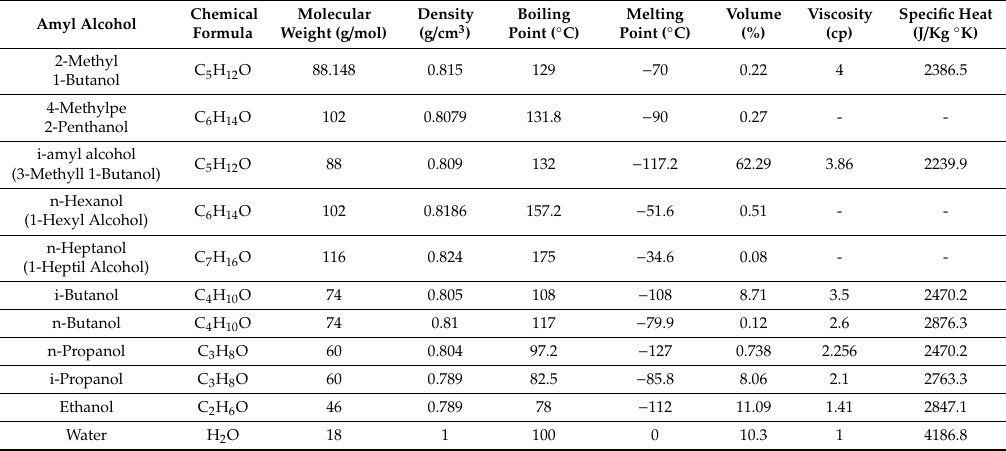
Table 1. Composition of fusel oil